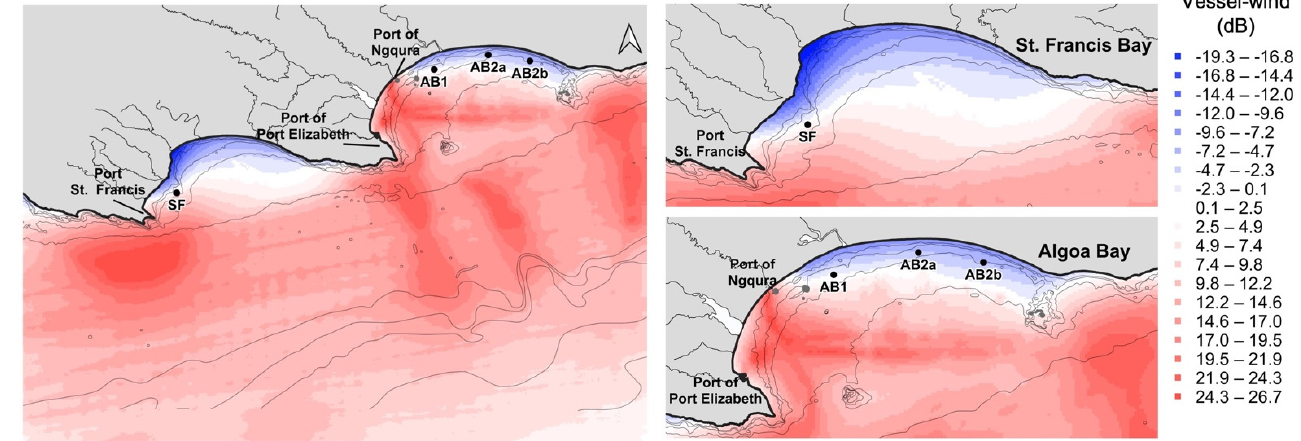
Figure 10. Modelled vessel noise less modelled wind noise in St. Francis Bay and Algoa Bay. Blue shades indicate areas where wind noise exceeded vessel noise, white area indicates the transition phase where vessel noise started to dominate wind noise, and red shades indicate areas where vessel noise exceeded wind noise.